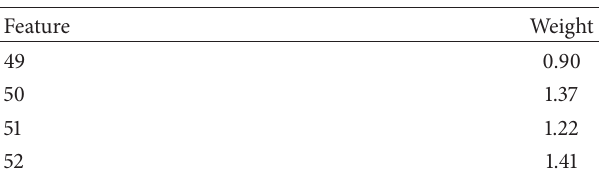
Table 2: Weight for each feature in the TE dataset. Table 2: Continued.